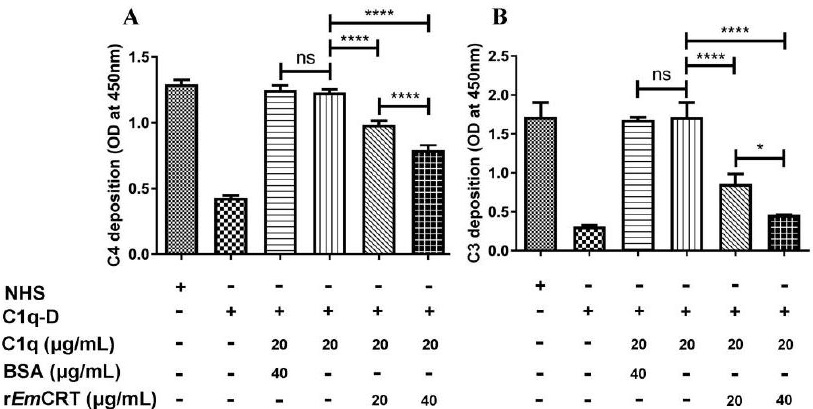
Figure 3. Inhibition of C1q-mediated C4/C3 generation by r Em CRT. C1q (20 µg/mL) was pre-incubated with r Em CRT (0, 20 or 40 µg/mL) or BSA, (40 µg/mL), then transferred into human IgM-coated